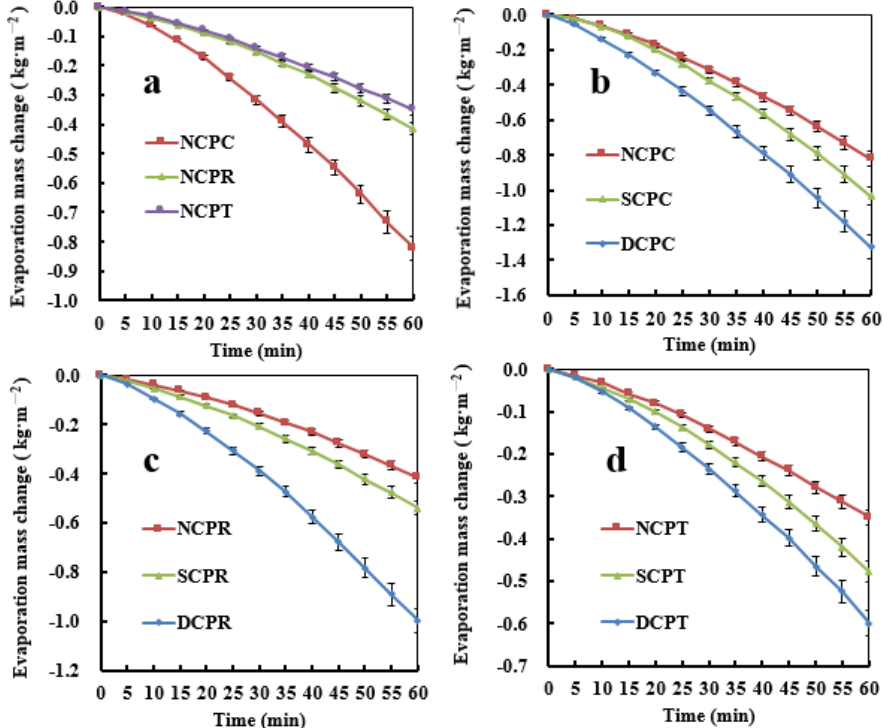
Figure 3. Changes in the quality of photoevaporation water of specimens under 1 kW·m –2 light intensity. ( a ) change in evaporation mass of untreated poplar in three sections; ( b ) change of evaporation mass in cross-section of specimens; ( c ) change in evaporation mass in the radial section of specimens; and ( d ) change in evaporation mass in the tangential section of specimens.